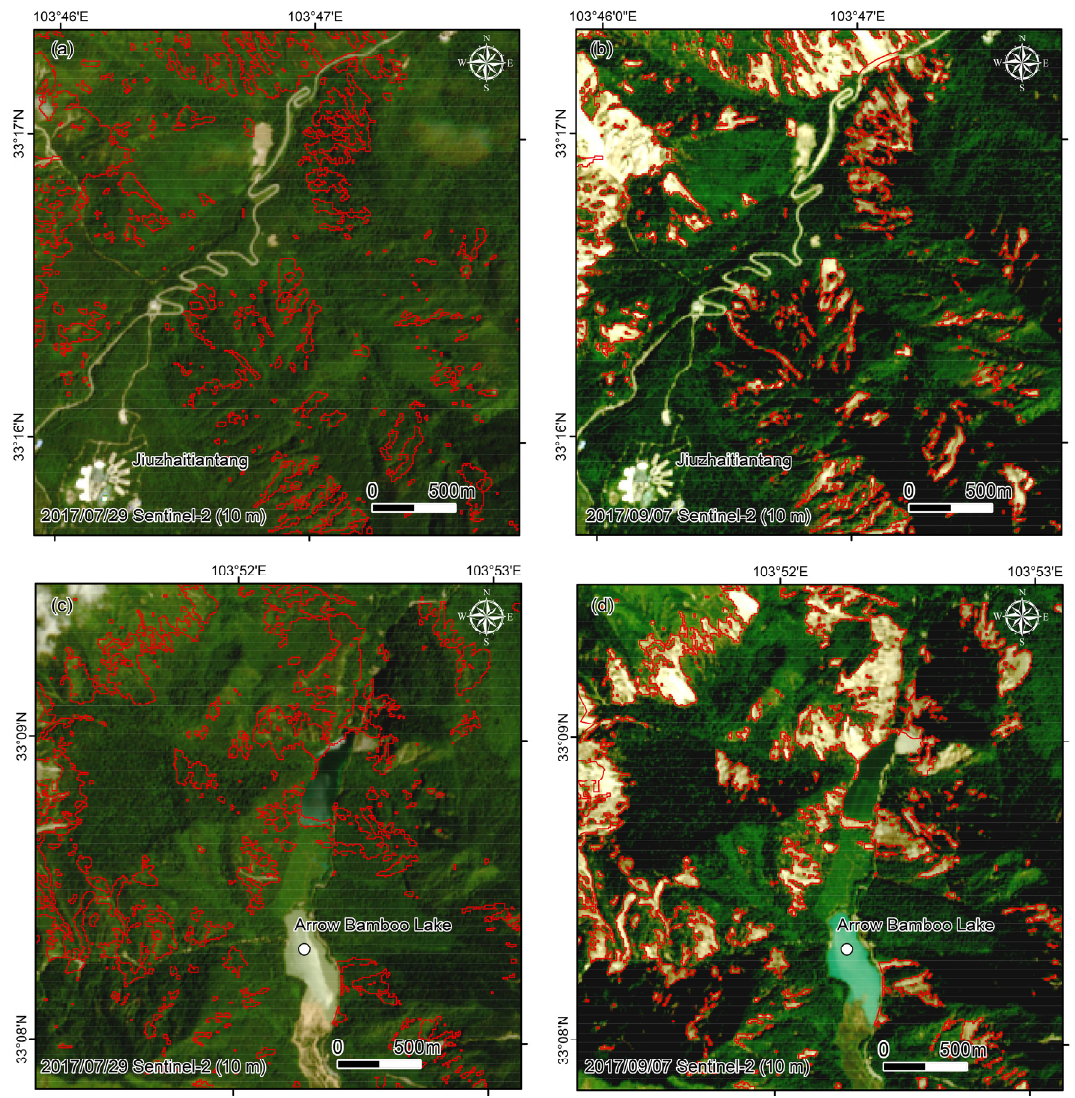
Figure 4. Interpretation examples of landslides related to the 8 August 2017 Jiuzhaigou Ms 7.0 earthquake from Sentinel-2 (10 m) and UAV (1 m) images. ( a , b ) Jiuzhaitiantang area before and after the 2017 Jiuzhaigou earthquake; ( c , d ) Arrow Bamboo Lake area before and after the 2017 Jiuzhaigou earthquake.